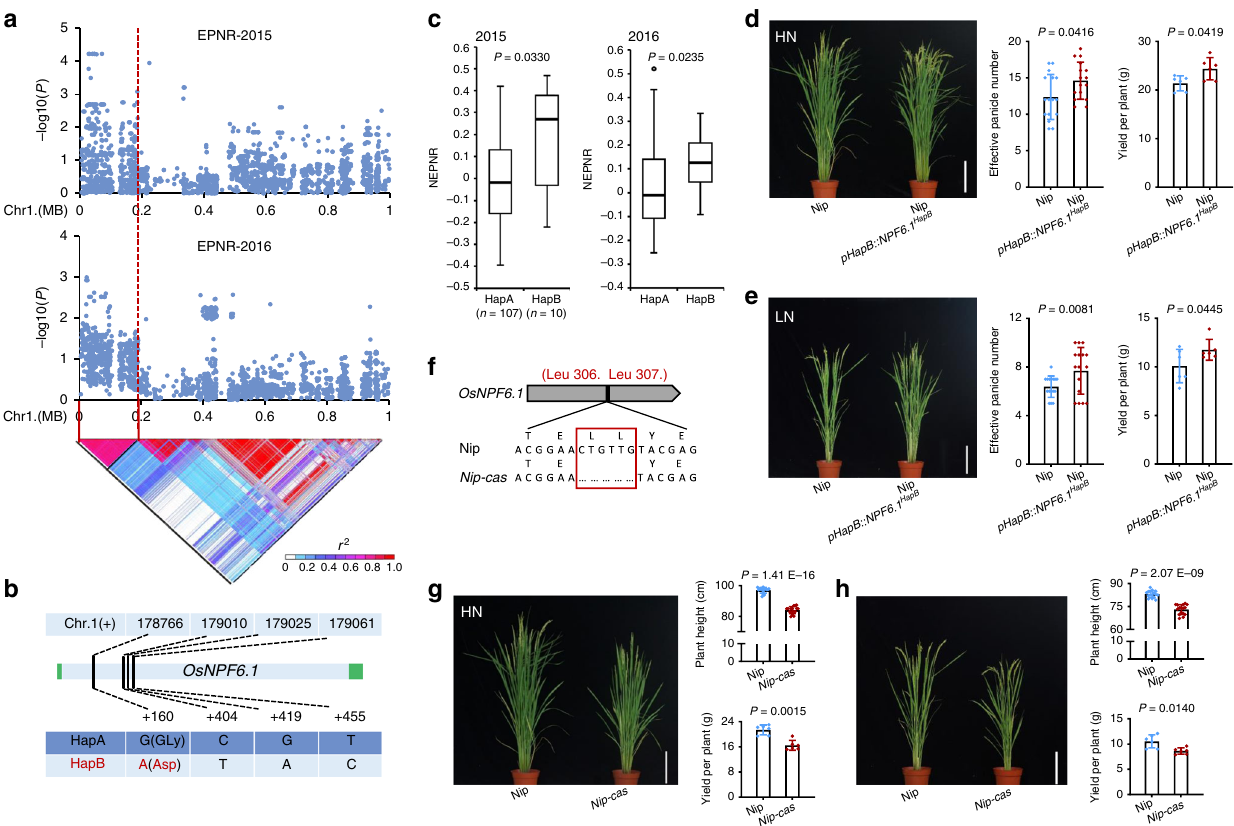
Fig. 1 Identi fi cation and functional validation of OsNPF6.1 on chromosome 1. a Local Manhattan plot (top) and LD heatmap (bottom) surrounding the peak on chromosome 1. Red dashed line indicates the candidate region for the peak. b Gene structure of OsNPF6.1 and DNA polymorphism in this gene. Green boxes and light blue box represent UTR and exon, respectively. c Comparative analyses of OsNPF6.1 between the low and high NUE haplotypes. NEPNR (normalized effective panicle number ratio)-2015 (left) and NEPNR-2016 (right) based on the haplotypes (Hap) of OsNPF6.1 . Box edges represent the 0.25 quantile and 0.75 quantile with the median values shown by bold lines. Whiskers extend to data no more than 1.5 times the interquartile range, and remaining data are indicated by dots. Differences between the haplotypes were analyzed by Welch ’ s t test. d , e Comparison of the effective panicle numbers and yields per plant of Nip and complementary line (Nip pHapB::NPF6.1 HapB ) in HN and LN, bar = 20 cm, n = 16, 6. f Two amino acids are deleted in Nip-cas . Red box indicates the missing amino acids. g , h Comparison of Nip and knock-out line ( Nip-cas ) plant heights and yields per plant under HN and LN conditions, bar = 20 cm, n = 16, 6. Data are presented as means± SD. P values (versus the Nip) were calculated with Student ’ s t test. Nip Nipponbare. The source data underlying Figs. 1d, e, g, and h are provided as a Source Data fi